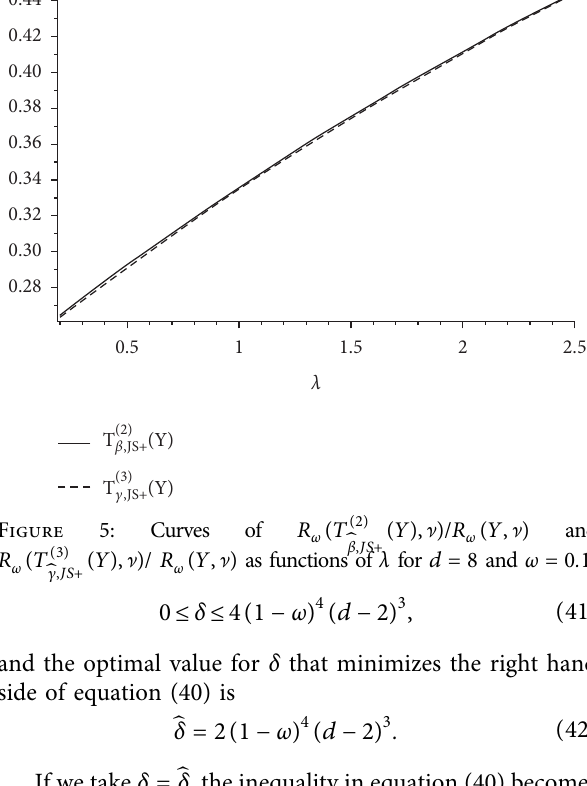
Figure 6: Curves of R R ( T ( 3 ) ( Y ) , ] ) / R 􏽢 c ,JS + ω